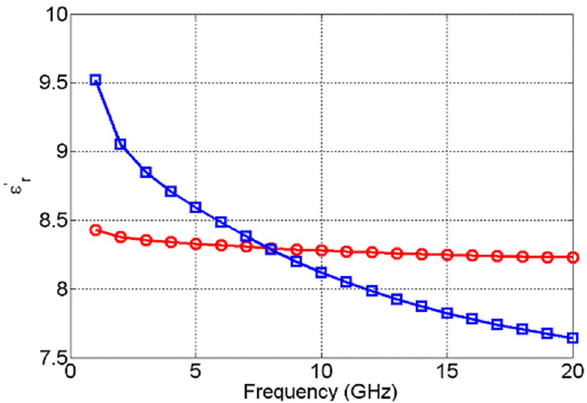
′ Figure 13. Extracted ε r of NiO in OFF state (red circles) and in ON state (blue squares).